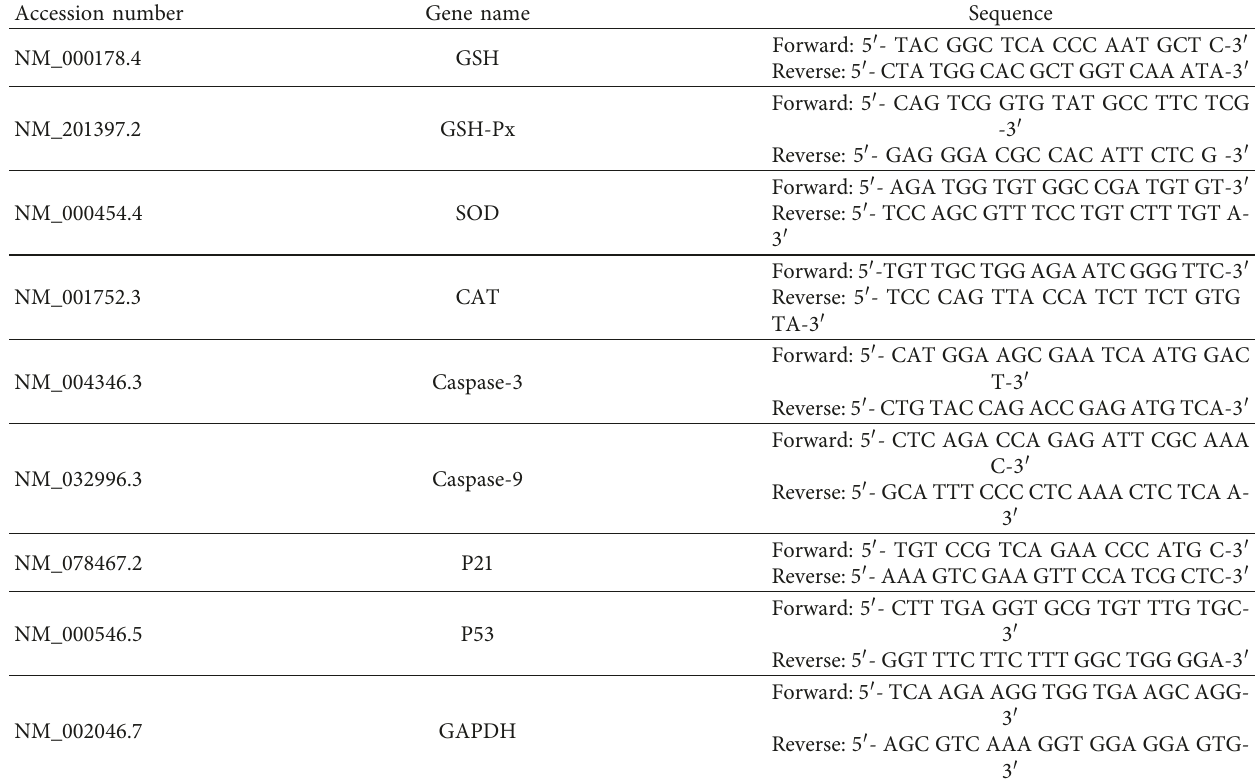
Table 1: The sequences of reverse transcription-polymerase chain reaction